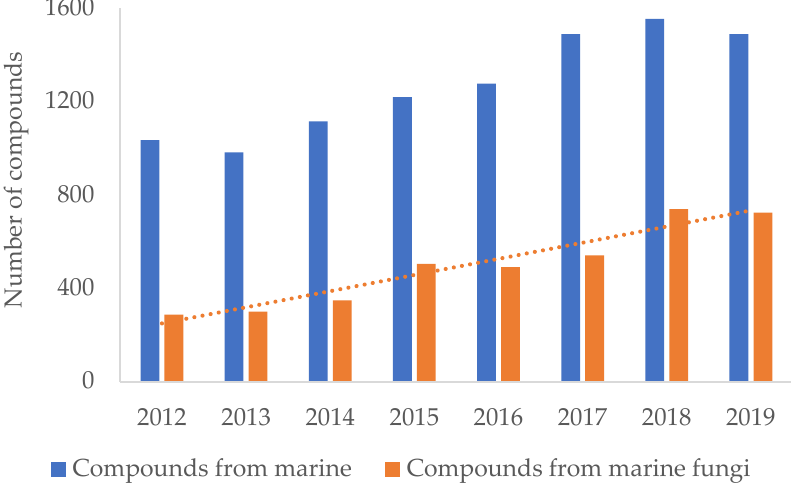
Figure 1. Numbers of new compounds from marine and marine-derived fungi from 2012 to 2019, data adapted from the serial review articles of Blunt et al. ([1–8]).